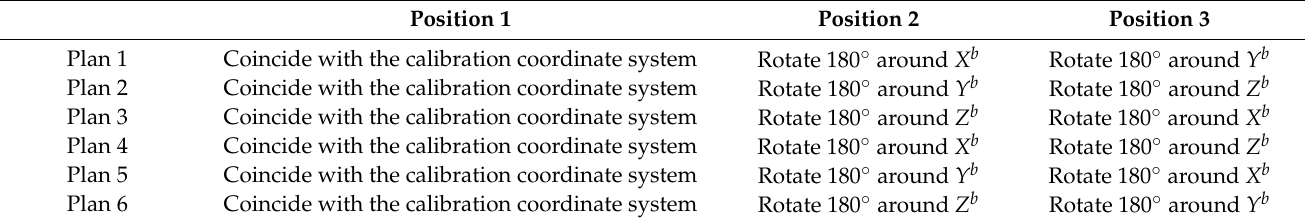
Table 1. Rotation sequence.